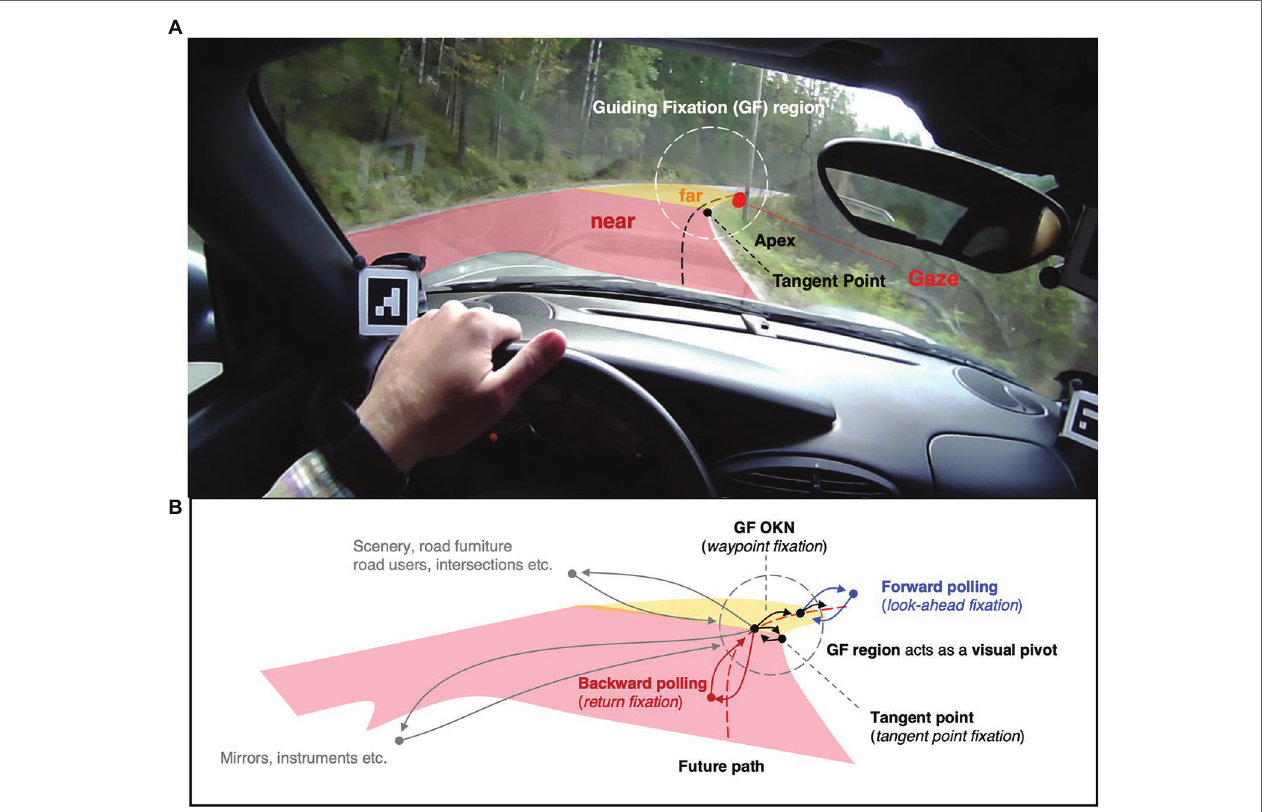
FIGURE 4 | Guiding fixations and the visual pivot strategy. This frame in this is taken about 2 s after the frame in Figure 3 : the driver has now arrived at the far road (TH2s) region and begun to turn into the bend. Gaze is looking ahead, guiding steering, and anticipating the upcoming end of the bend. (A) . Most of the time gaze is concentrated in a small region of the visual field—the guiding fixation (GF) region. The concept of guiding fixations can be operationally defined in terms of time headways, between about 1–2 s TH. (B) . The GF region acts as a visual pivot, from which saccades are launched, and to which saccades return. Scenery and in- car fixations are eyes off the road fixations, the rest are eyes-on-the-road fixations. Gaze polling: i. saccade lands further ahead than the far road GF region and returns (look-ahead fixation, forward polling) ii. saccade made back to the near road and the back to GF region (return fixation, backwards polling). Tangent point fixation: saccade to the tangent point (a travel point on the inside lane edge). GF OKN: future path waypoint (or reference point) fixation. For these Guiding Fixations (the majority), the eye does not remain stable in its orbit: these guiding fixations are “tracking fixations.” The line of sight is locked onto locations in the 3D scene one is moving through. (Note: This is a schematic representation; what is here indicated by individual gaze points may be glances comprised of multiple fixations; and not all glances in the periphery always return to the pivot in a rigidly mechanical